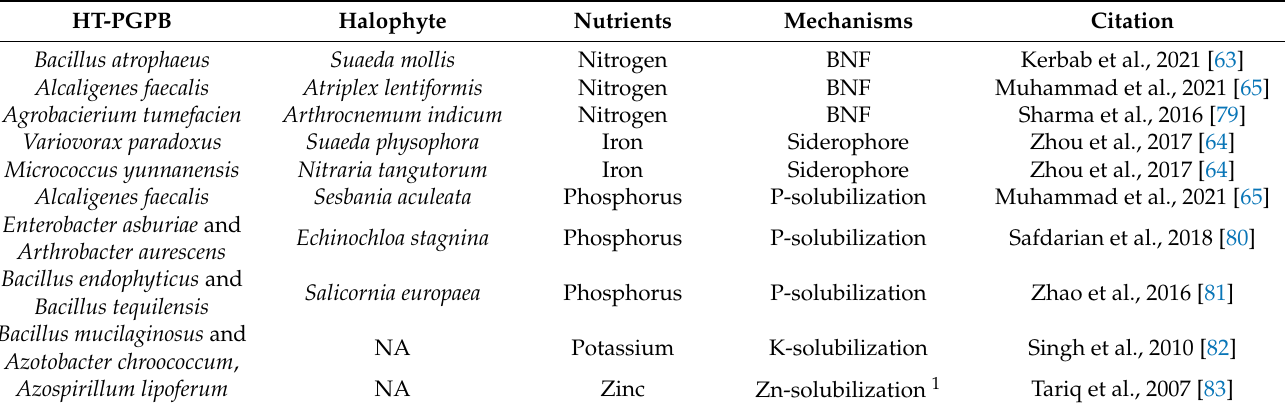
Table 2. Halophytes associated HT-PGPB with the ability to improve different soil nutrient